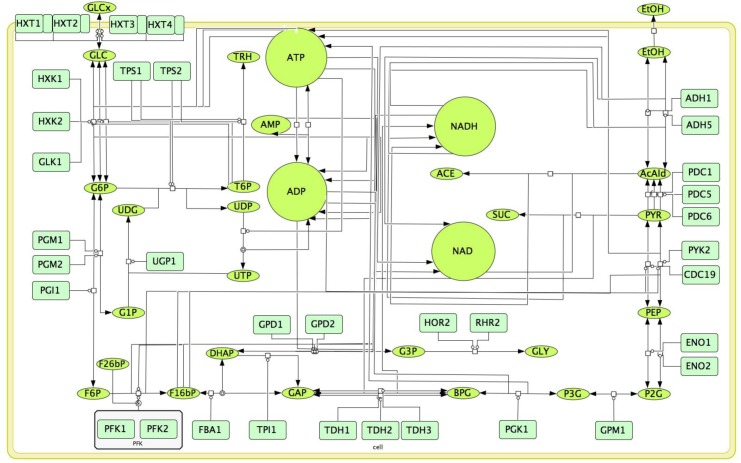
Schematic representation of the kinetic model of glycolytic metabolism used in this study (Smallbone et al., 2013).The diagram is drawn using the Systems Biology Graphic Notation (Le Novère et al., 2009).